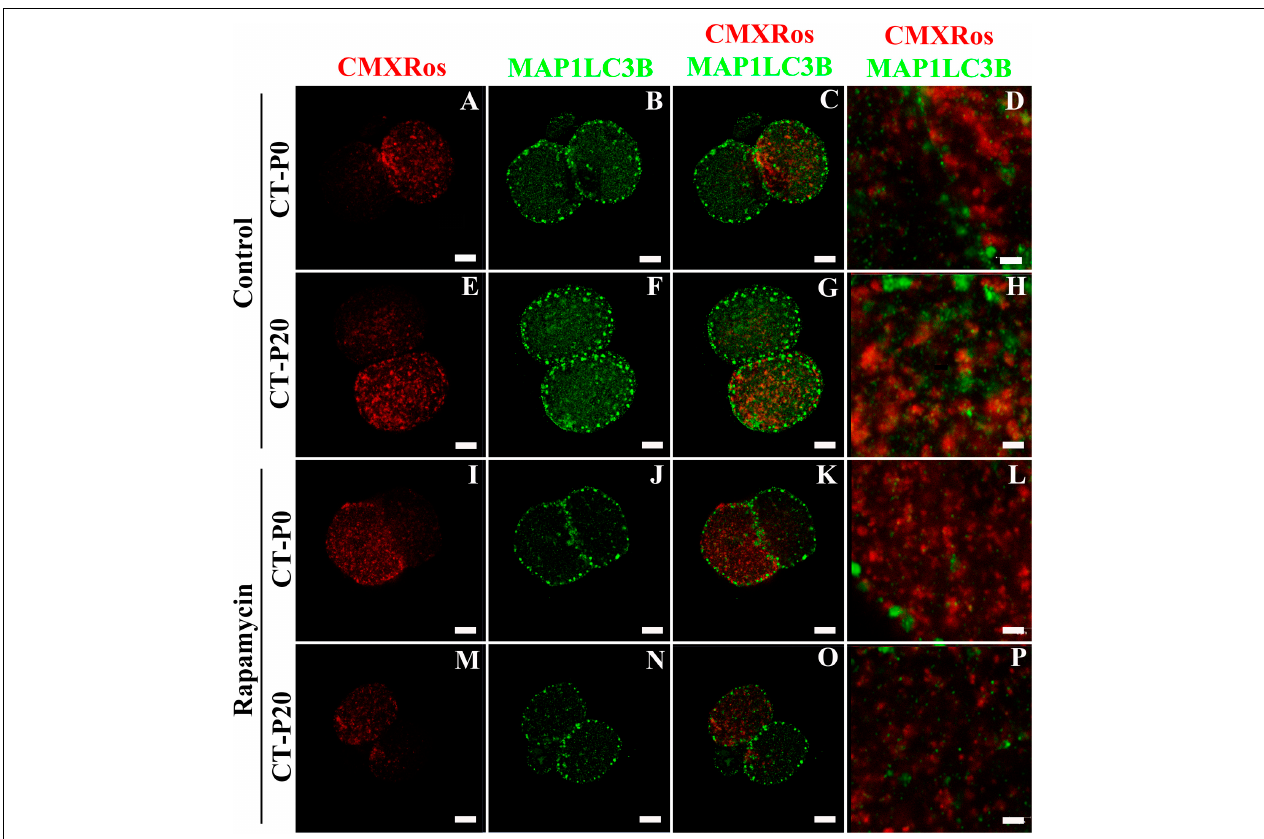
FIGURE 4 | Autophagy is not linked with elimination of photoirradiated mitochondria in early embryos. CMXRos-loaded zygotes were photoirradiated for either 0 (P0) or 20 (P20) s to induce mitochondrial damage. Mitochondria from these zygotes were injected by cytoplasmic transfer (CT) into recipient zygotes, resulting in CT-P0 (A-D and I-L) and CT-P20 (E-H and M-P) groups, respectively. CT-derived zygotes were cultured in vitro for 24 h in either absence (A–H) or presence (I–P) of rapamycin. Autophagosomes in two-cell embryos were detected by immunofluorescence using a primary antibody against MAP1LC3B (green; B,F,J,N ). Injected mitochondria were visualized based on CMXRos fluorescence (red; A,E,I,M ). Pictures were merged to assess mitochondria-autophagosome colocalization (C,G,K,O,D,H,L,P) . Bars in (A–C,E–G,I–K,M–O), and M–O correspond to 10 µ m, while in (D,H,L,P), they correspond to 2 µ